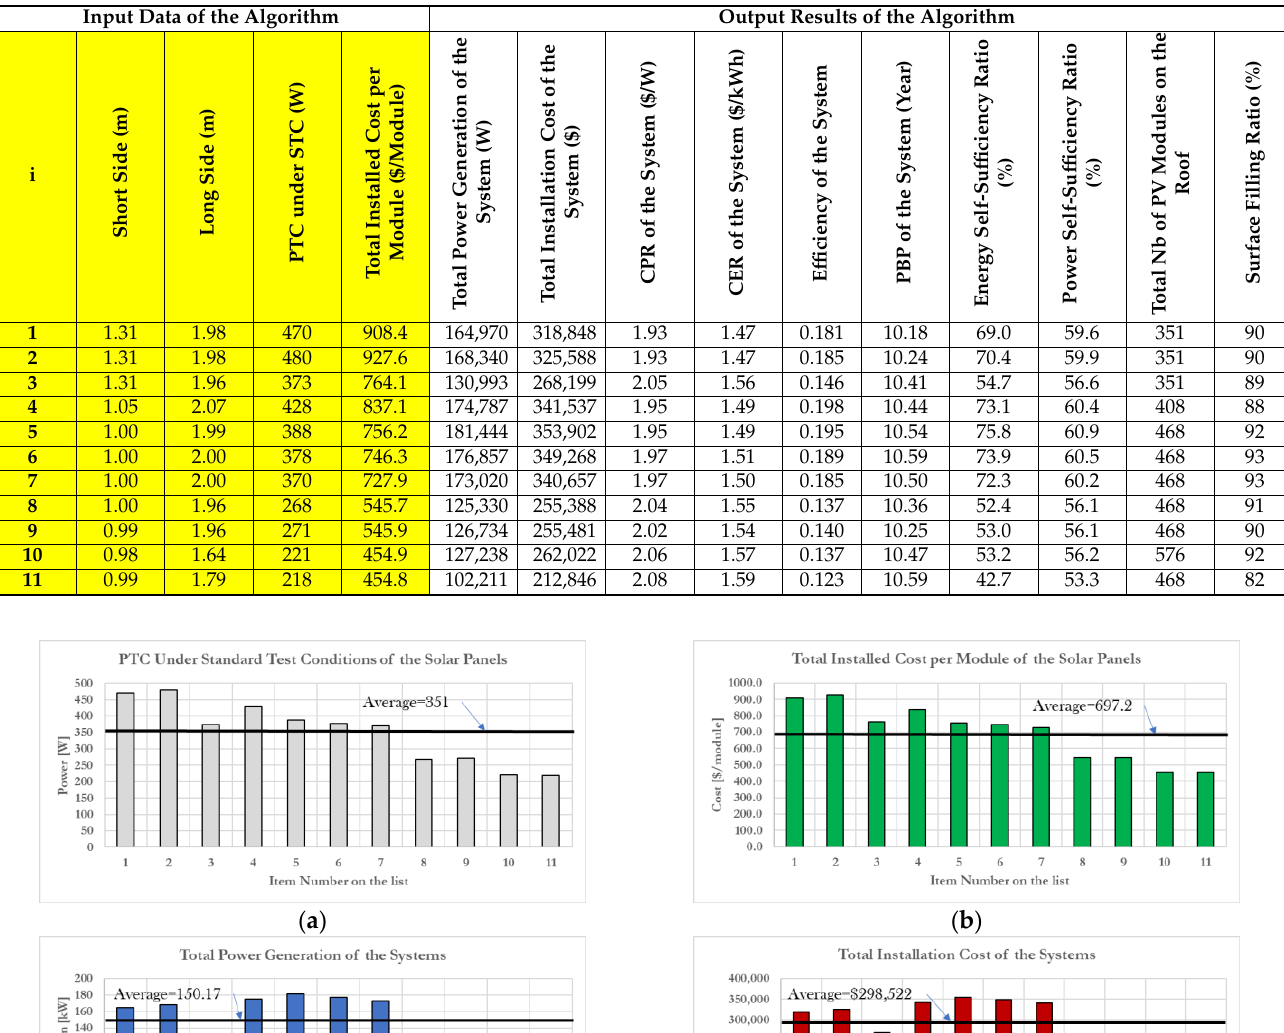
Table 2. Results of the calculation.